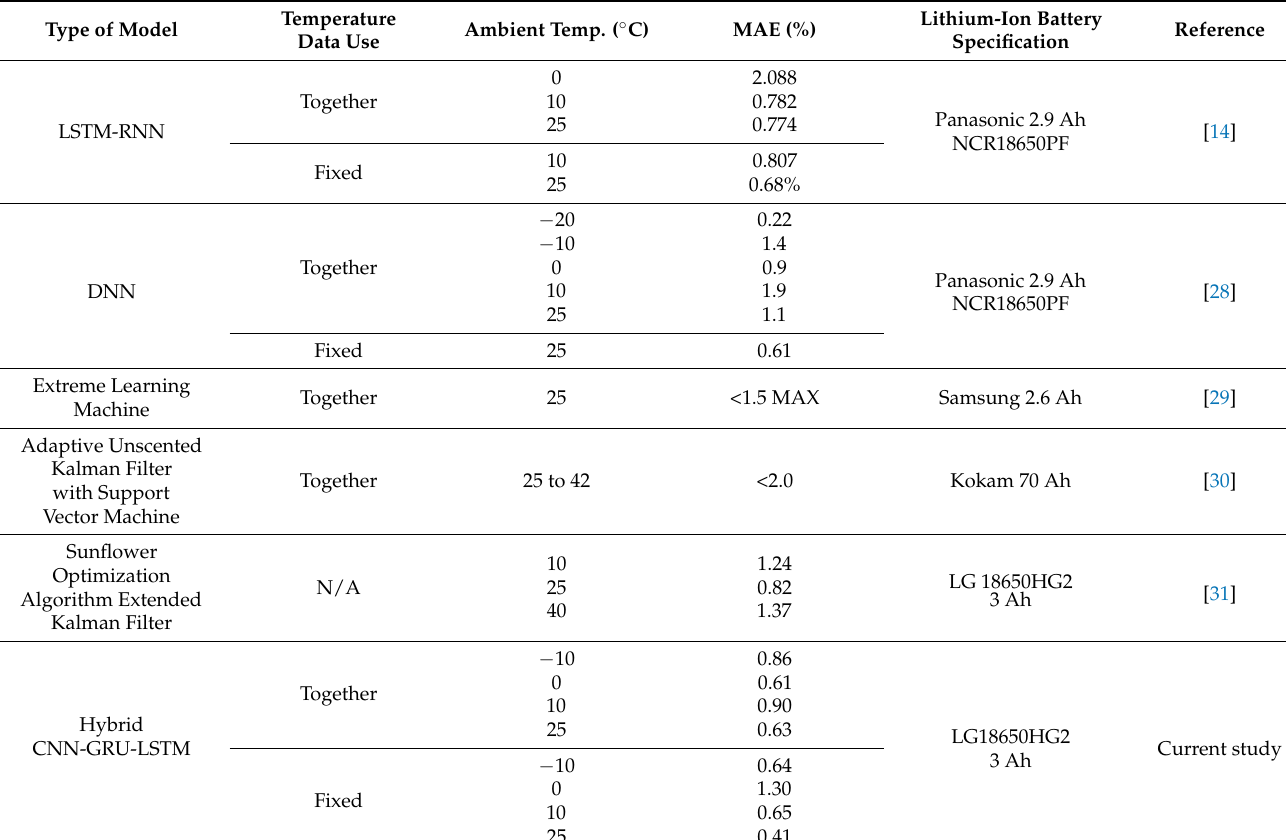
Table 8. Comparative analysis for the five